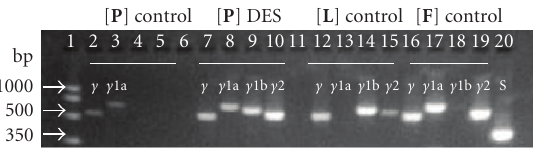
Figure 5: RT-PCR amplification of PPAR γ ( γ , γ 1a, γ 1b, and γ 2) splice variants in the body of the penis ( P ) of control (lanes, 2–5) and DES-treated (lanes, 7–10) 28-day-old rats. Lanes 12–15 were amplification products from RNA template obtained from rat liver ( L ) (used as positive control for PPAR γ 1b). Lanes 16–19 were RNA template from rat white adipose tissue ( F ) (used as positive control for PPAR γ 1a and PPAR γ 2). Note that only PPAR γ and PPAR γ 1a were detected in ( P ) of normal rats. In contrast, in DES-treated rats enhanced expression of all PPAR γ splice variants can be noted. In addition to PPAR γ and PPAR γ 1a expression (seen in normal rats), PPAR γ 1b and PPAR γ 2 were induced by DES-treatment. As expected, PPAR γ 1b and PPAR γ 2 were strongly expressed in ( L ) and ( F ), respectively. S-15 (S, lane 20) is a housekeeping gene amplified from ( P ) as control for RT-PCR conditions. The expected amplicon sizes for S, PPAR γ 1a, PPAR γ 1b, PPAR γ 2, and PPAR γ are 361, 658, 618, 563, and 533 bp, respectively.